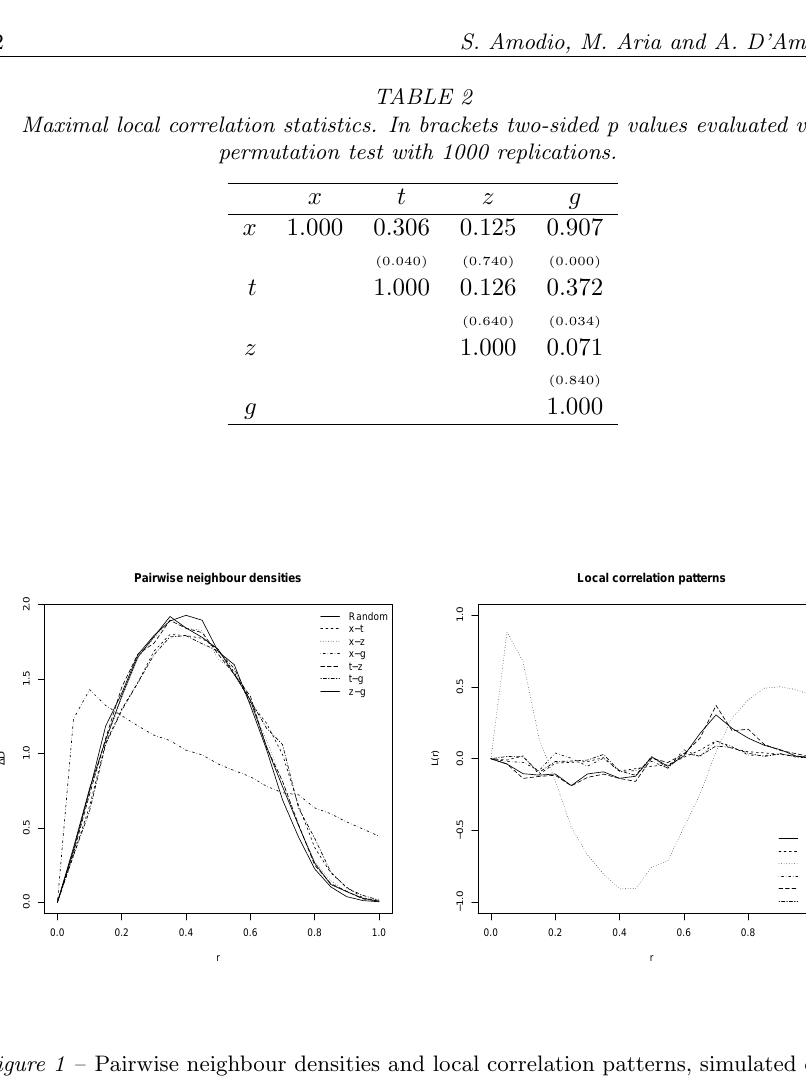
data, the results were unaltered. As null distribution we used a normal bivariate distribution with correlation equal to